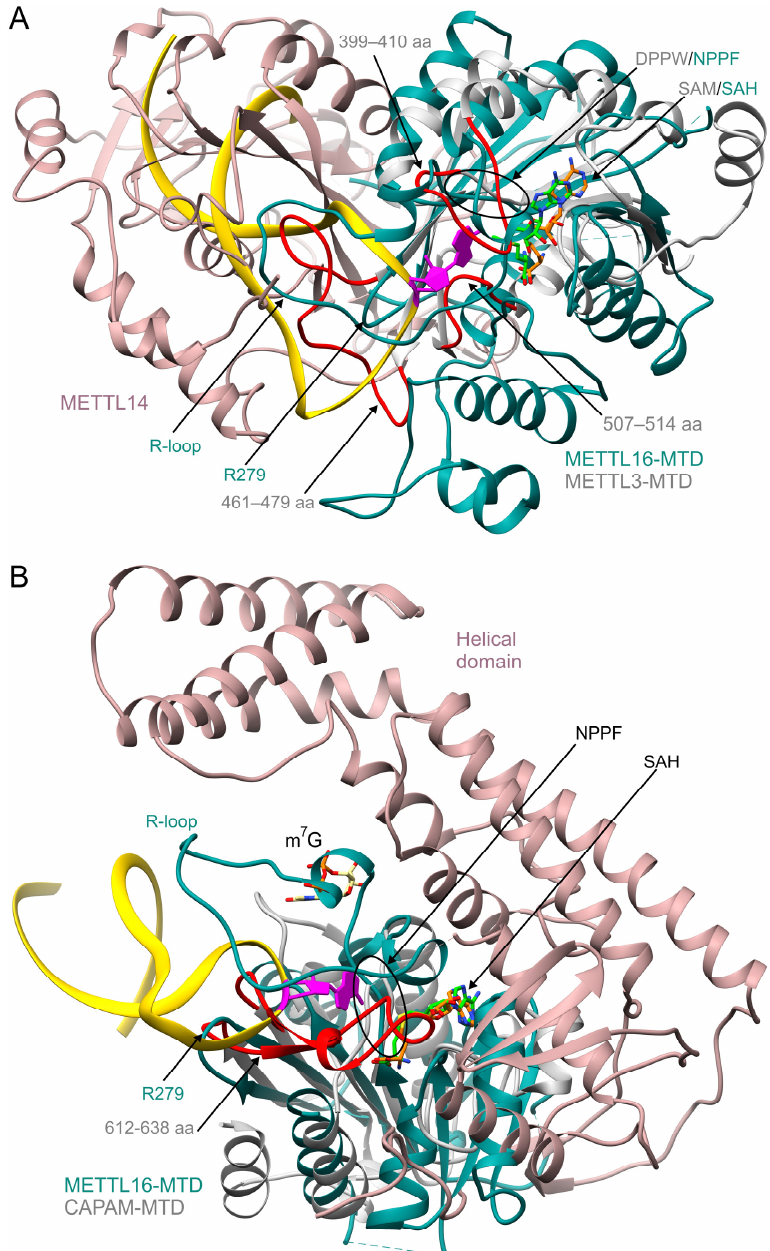
Figure 3. Structural comparison between the MTD domain of METTL16 and the MTDs of human mRNA and ncRNA m 6 A MTases. METTL16-MTD (2–310 aa, turquoise)/hp1x RNA (gold) model (PDB ID: 6du4) was used for superposition with two other human MTases; SAH (orange) was modeled into the coenzyme binding pocket of METTL16-MTD/hp1x using METTL16-MTD/SAH structure (6gfn); the acceptor adenosine is in magenta. Catalytic domains of superimposed MTases are gray; their additional subunits or domains are rosy brown; SAH or SAM are neon green; red indicates structural elements likely contributing to the substrate specificity. Panels present superposition of human METTL16-MTD/hp1x/SAH structure with ( A ) METTL3/METTL14/SAM complex (5il1); ( B ) CAPAM/SAH complex (6irw), residues 2–78 of METTL16 are hidden for clarity, the m 7 G cap is modeled using CAPAM/SAH/m 7 G structure from zebrafish